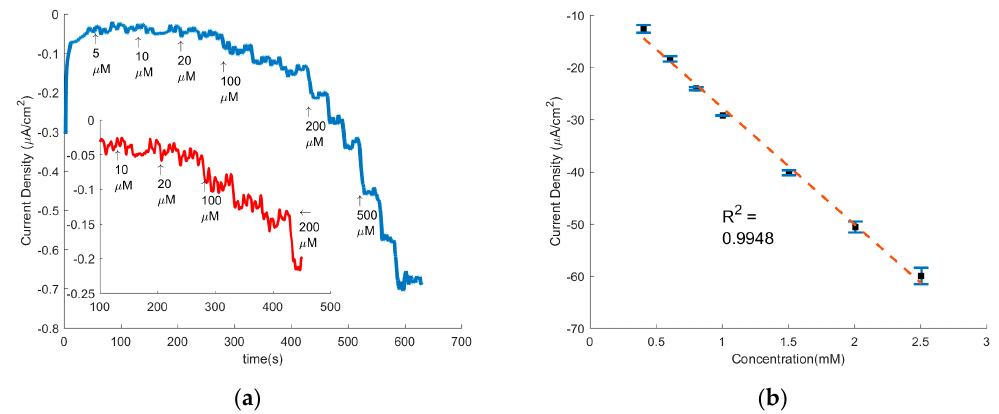
Figure 6. ( a ) Chronoamperometry of the Mechanically Treated CNF electrode running at − 0.5 V. Each addition concentration is indicated on the graph and was repeated three times after the initial indication prior to the next concentration addition. The inset is a zoomed in portion of the main graph; ( b ) Concentration vs. Current Density data from the chronoamperometry fitted with linear regression trend line.